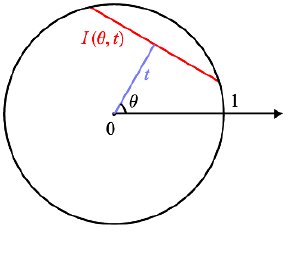
Figure 1. The chord I